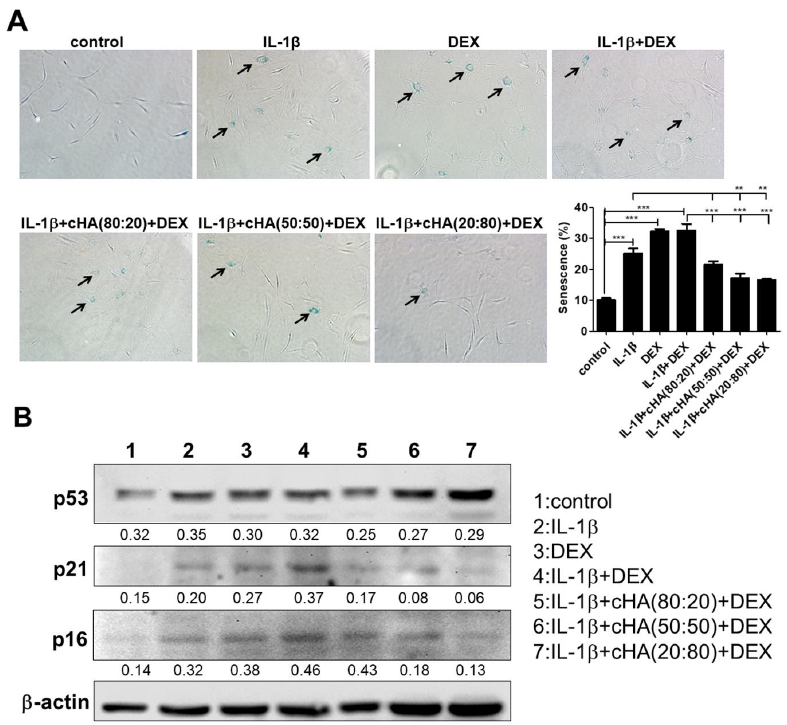
Figure 3. Effects of cHA with DEX in cellular senescence. Human primary tenocytes were treated with different formulations of cHA (cHA:linearized HA = 80:20, or 50:50, or 20:80, at the concentration of 2.5 mg/mL), DEX (100 µ M), and combinations of cHA with DEX (100 µ M) in response to IL-1 β (1 ng/mL) stimulation. ( A ) Senescence β -galactosidase (SA β -gal) staining showed positive cells in IL-1 β , DEX-, combinations of cHA with DEX-treated tenocytes. Arrows indicate SA β -gal-positive cells. ( B ) Immunoblotting for p53, p21, and p16 expressions in the three formulations of cHA with DEX. Values are the mean ± SEM ( n = 3). ** p < 0.01, *** p < 0.001.